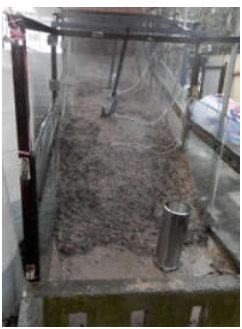
Figure 10. Slope morphology after test (Test 5).